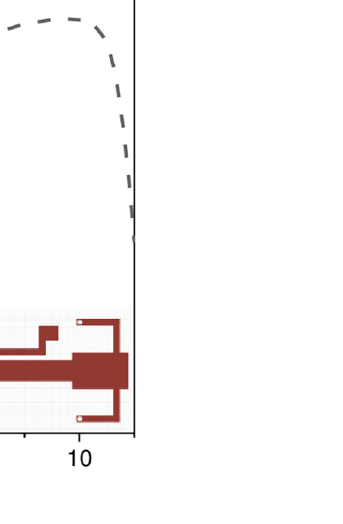
Fig 5. Experimental frequency plot of a single NB using lower T-shaped